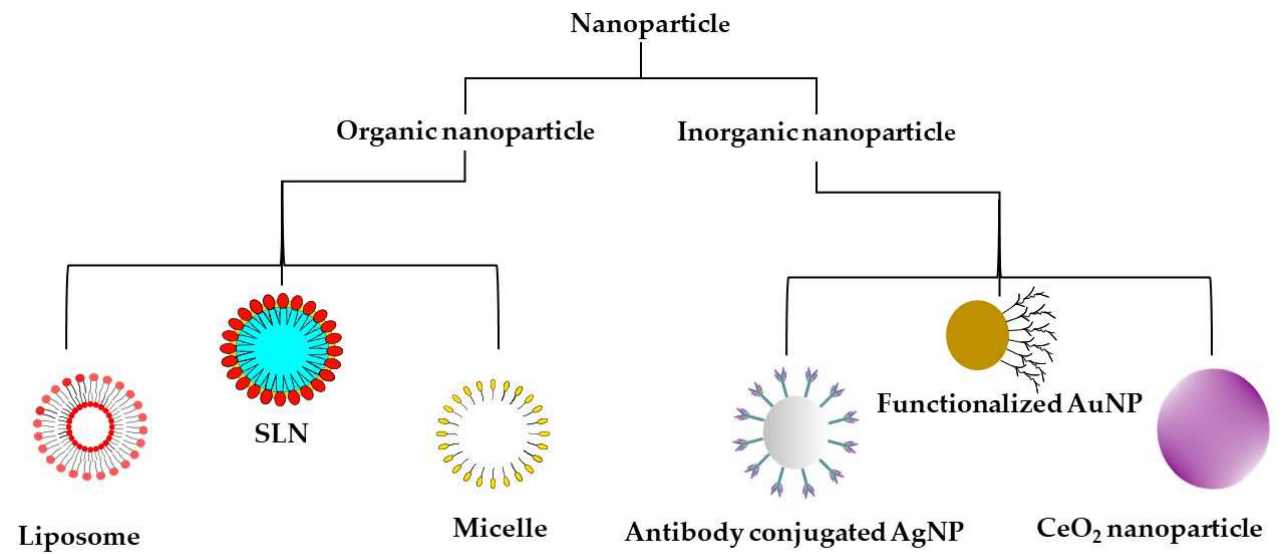
Figure 2. Types of nanoparticles most commonly used for the management of neurodegenerative disorders. SLN—solid lipid nanoparticle; AuNP—gold nanoparticle, AgNP—silver nanoparticle, CeO 2 NP—cerium oxide nanoparticle.